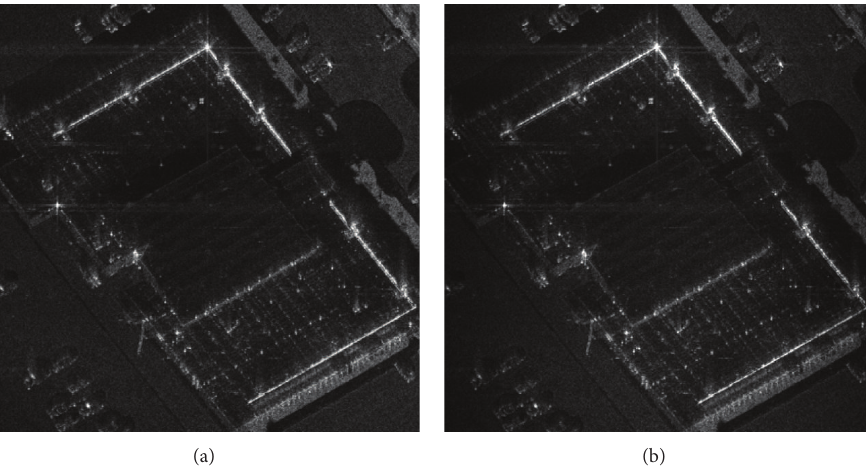
Figure 6: (a) The simulation scene imaging. (b) Focused result after processing the raw data generated by proposed frequency domain simulator.